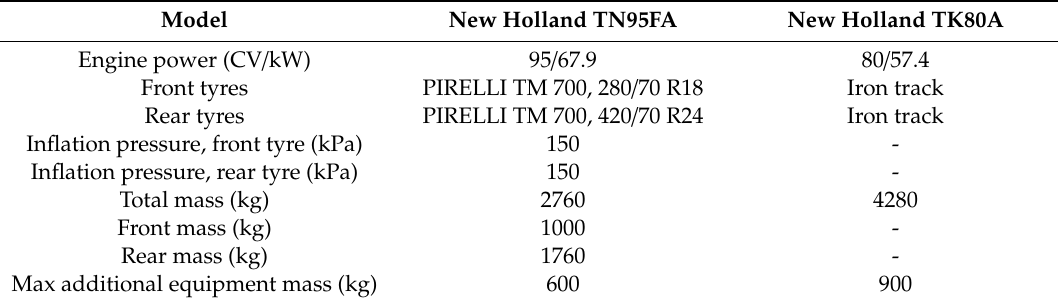
Table 1. Tractors’ characteristics.